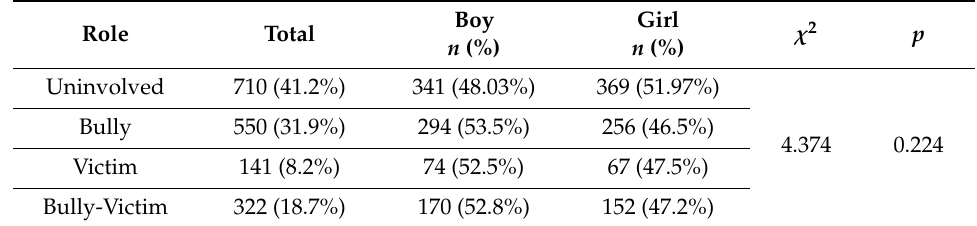
Table 1. Frequency and Percentage of Bullying by Role.